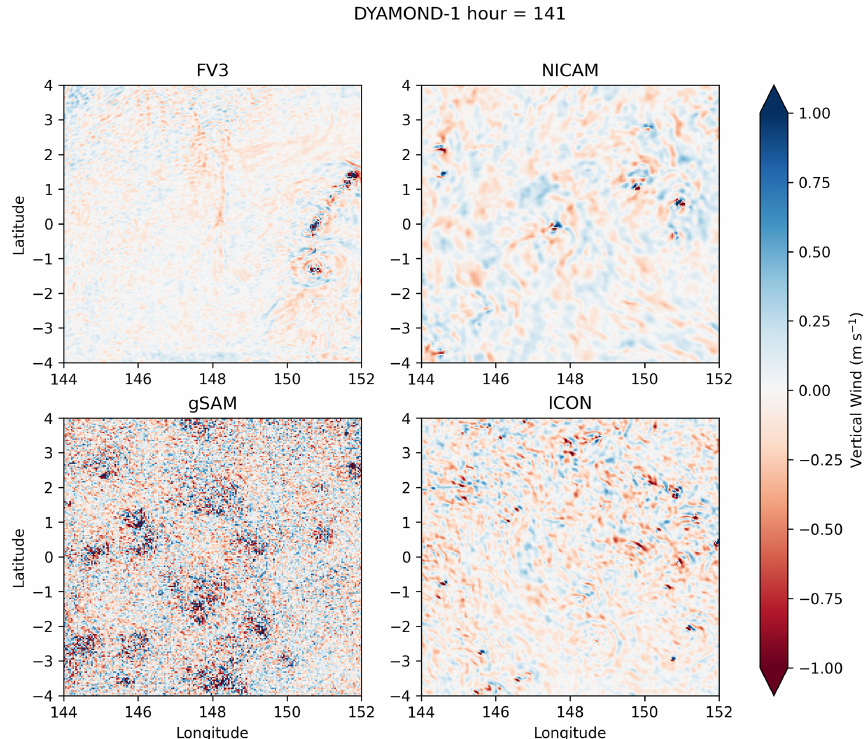
Figure 7. Snapshots of vertical wind from hour 141 in the DYAMOND-1 simulations. Winds are taken from the model level closest to 14.2km, and the tropical west Pacific region is